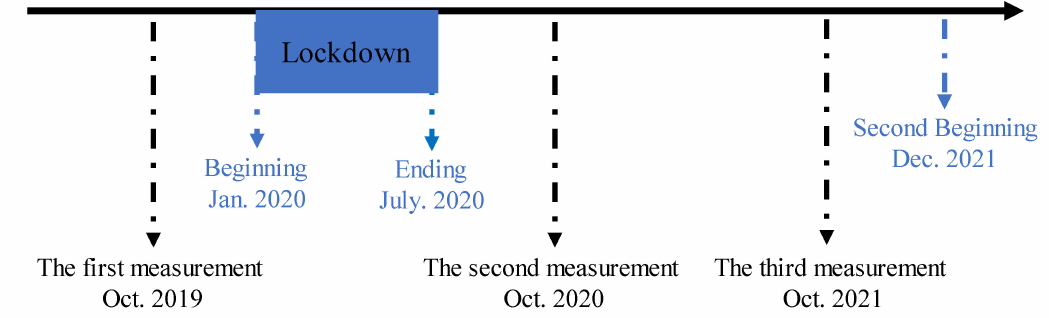
Figure 1. The timeline of COVID-19 pandemic in Shaanxi and the time of